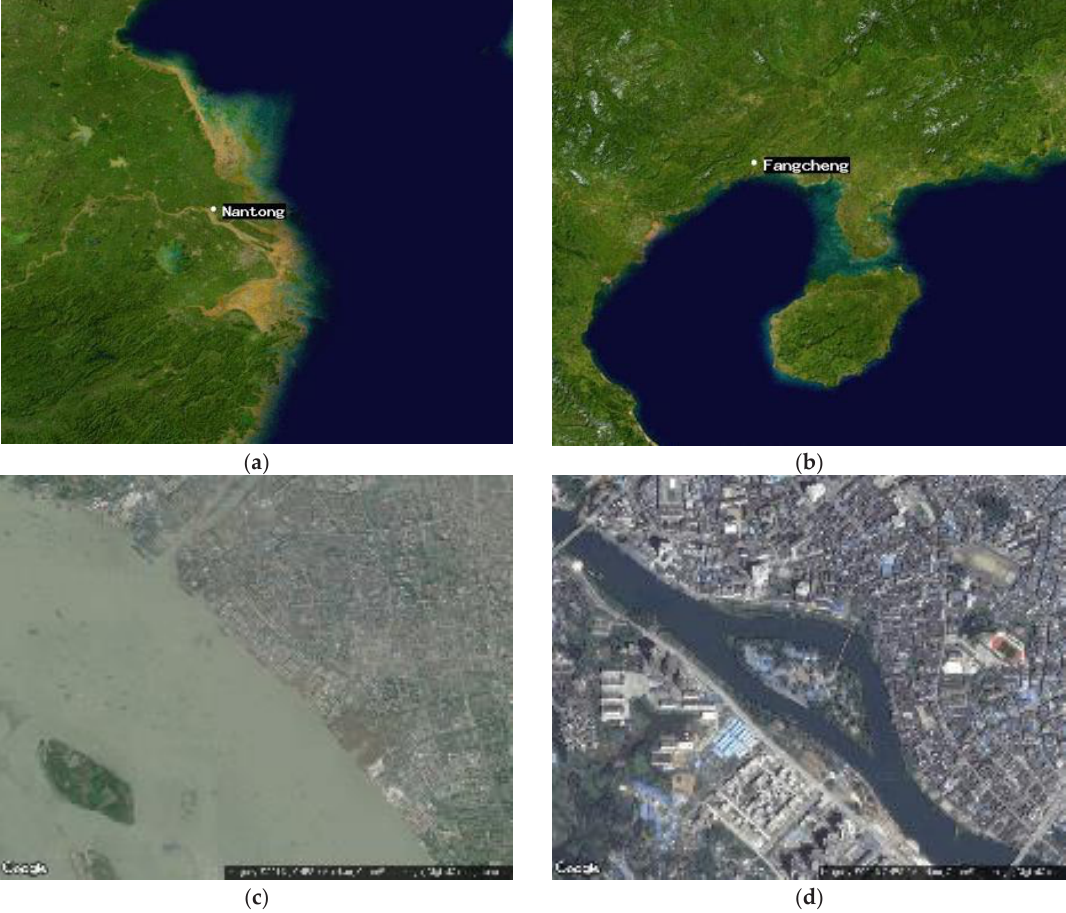
Figure 5. Location of Nantong Port ( a ) and Fangcheng Port ( b ) in China, and the satellite maps of Nantong ( c ) and Fangcheng ( d ).